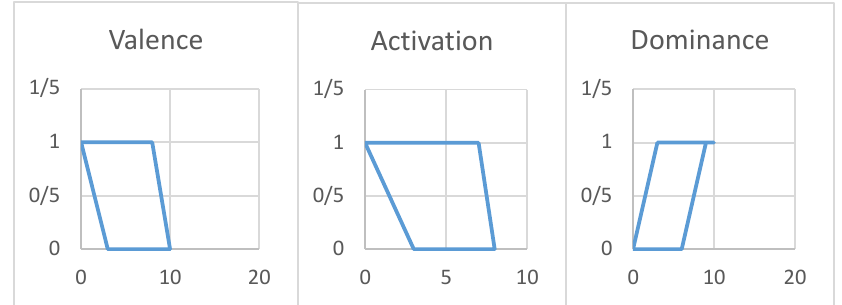
Fig. 11. The FOU of Ntukwasi (Trust) for dimensions valence, activation and dominance.